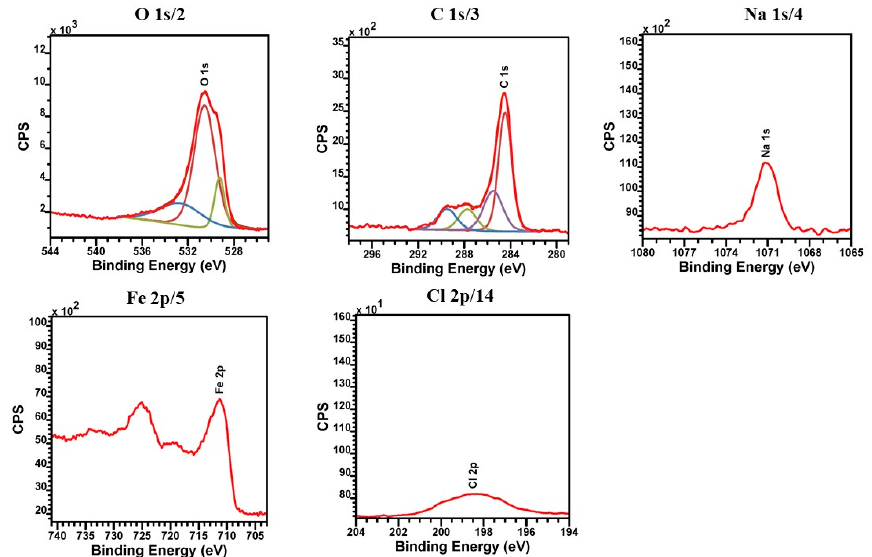
Figure 5. High resolution O 1s, C 1s, Na 1s, Fe 2p, and Cl 2p XPS peaks obtained on the surface of the S235 low-carbon steel substrate after five days of treatment in 3.5% NaCl solution (colors indi- cate typical bonds, details in the text).